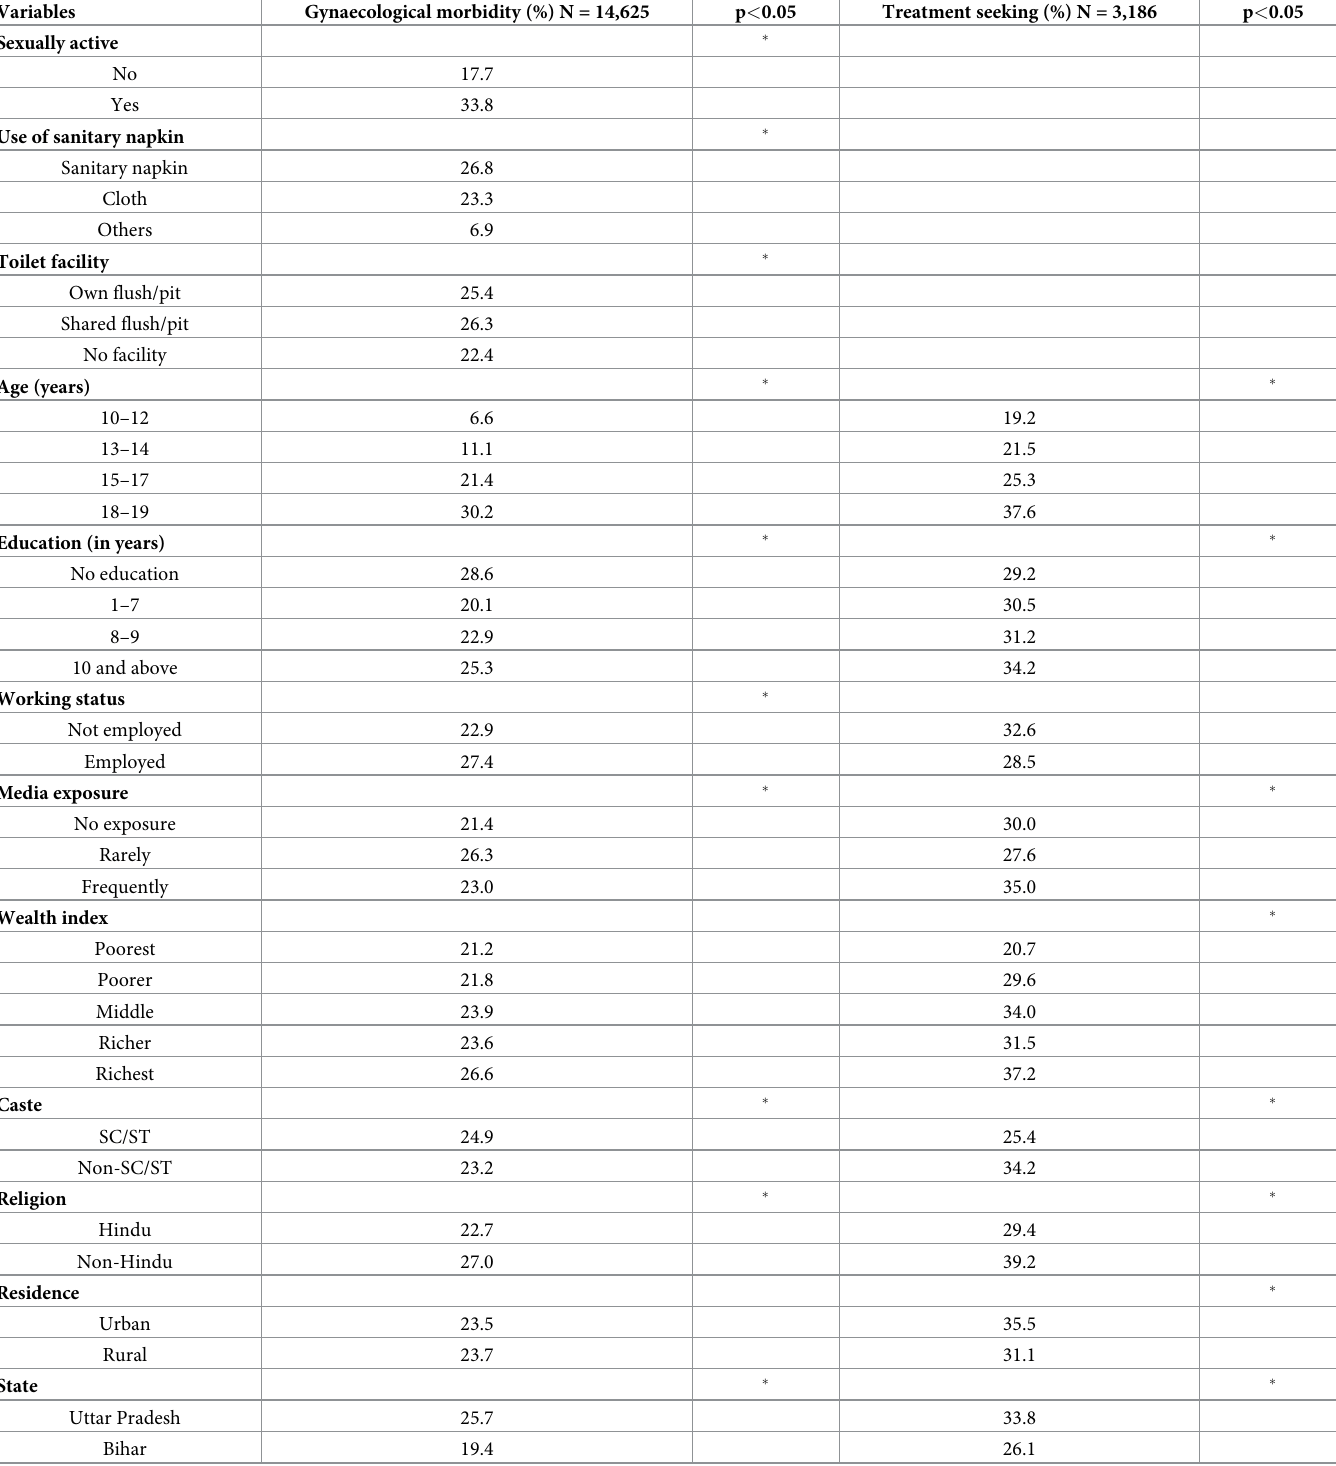
Table 2. Prevalence of gynaecological morbidity and its treatment-seeking behavior among adolescent girls aged 10–19 years by demographic and socio-economic